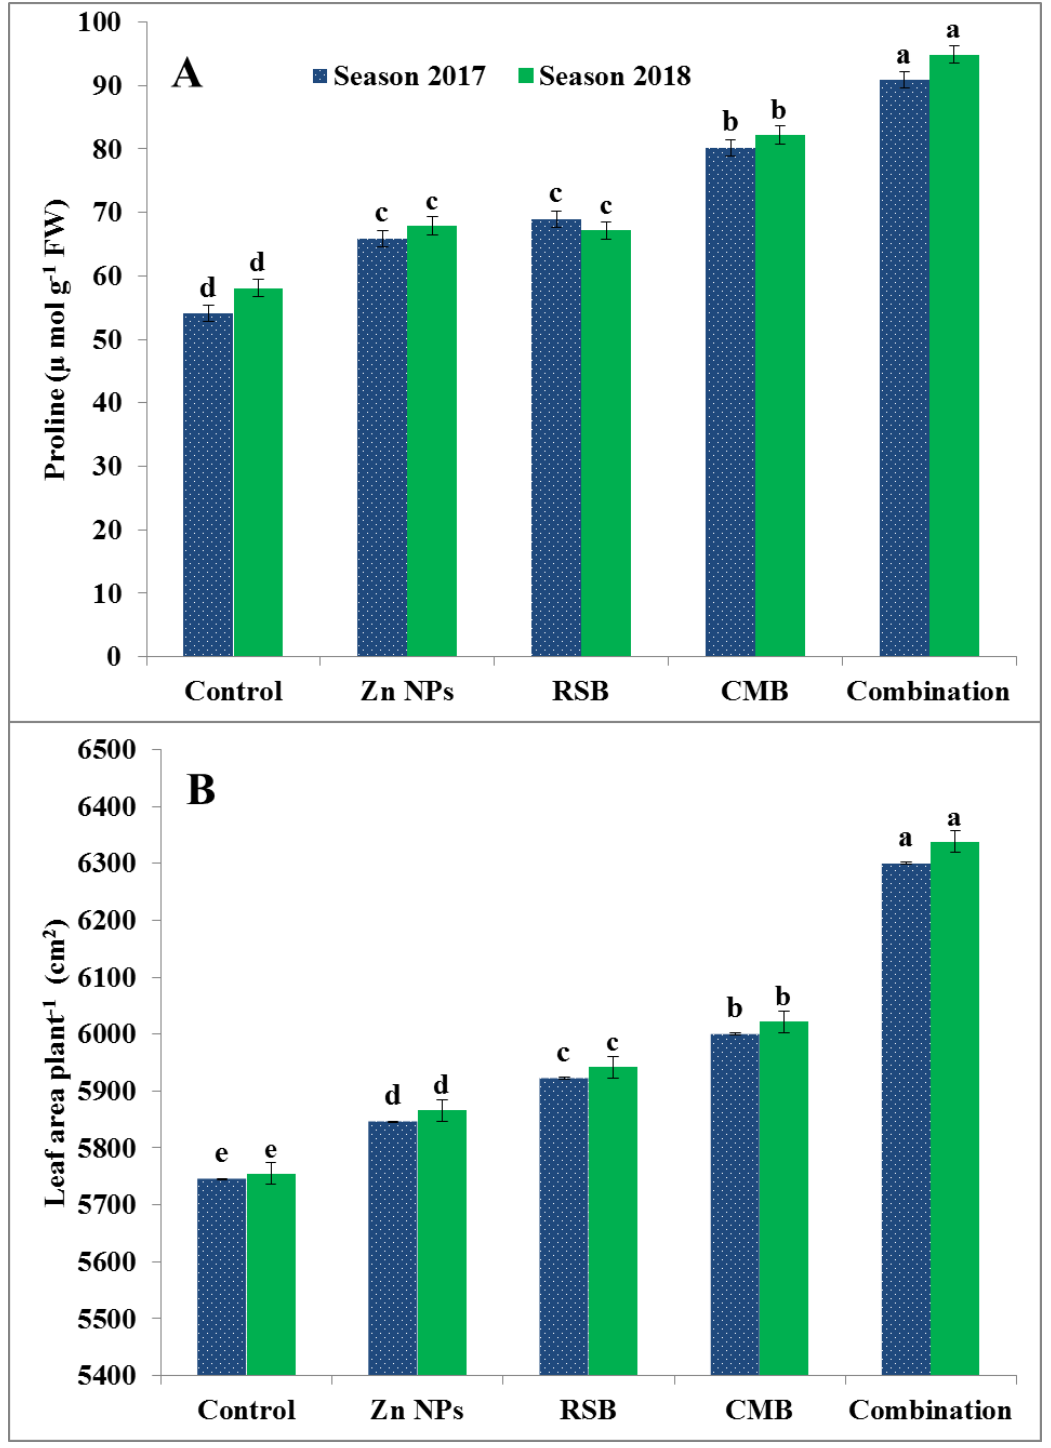
Figure 4. Effect of zinc nanoparticles, and biochar of rice-straw and cow-manure on proline content ( A ) and total leaf area ( B ) of sunflowers grown in soil irrigated with wastewater for long-term. Zn NPs = Zinc nano-particles, RSB = Rice straw biochar, CMB = Cow manure biochar, FW = fresh weight. SEM = Standard error of means, Means with di ff erent superscripts a–e are significantly di ff erent at p ≤ 0.05. Tukey’s test was applied to compare